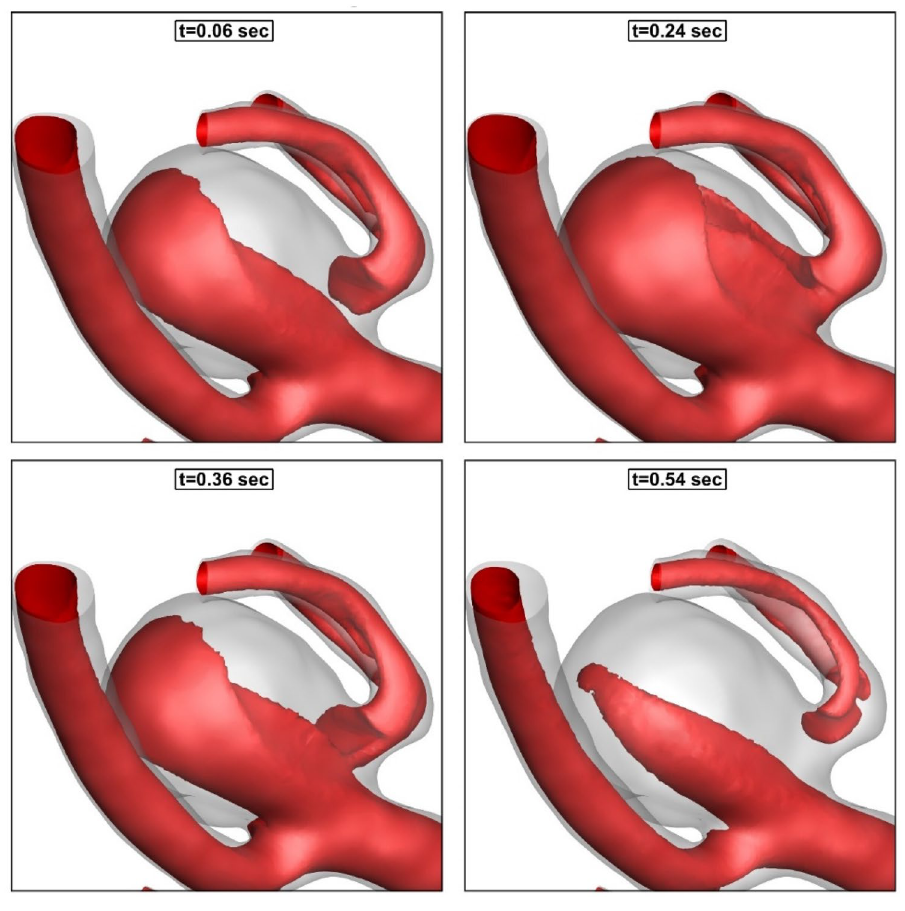
Figure 7. Iso-velocity (V = 0.5